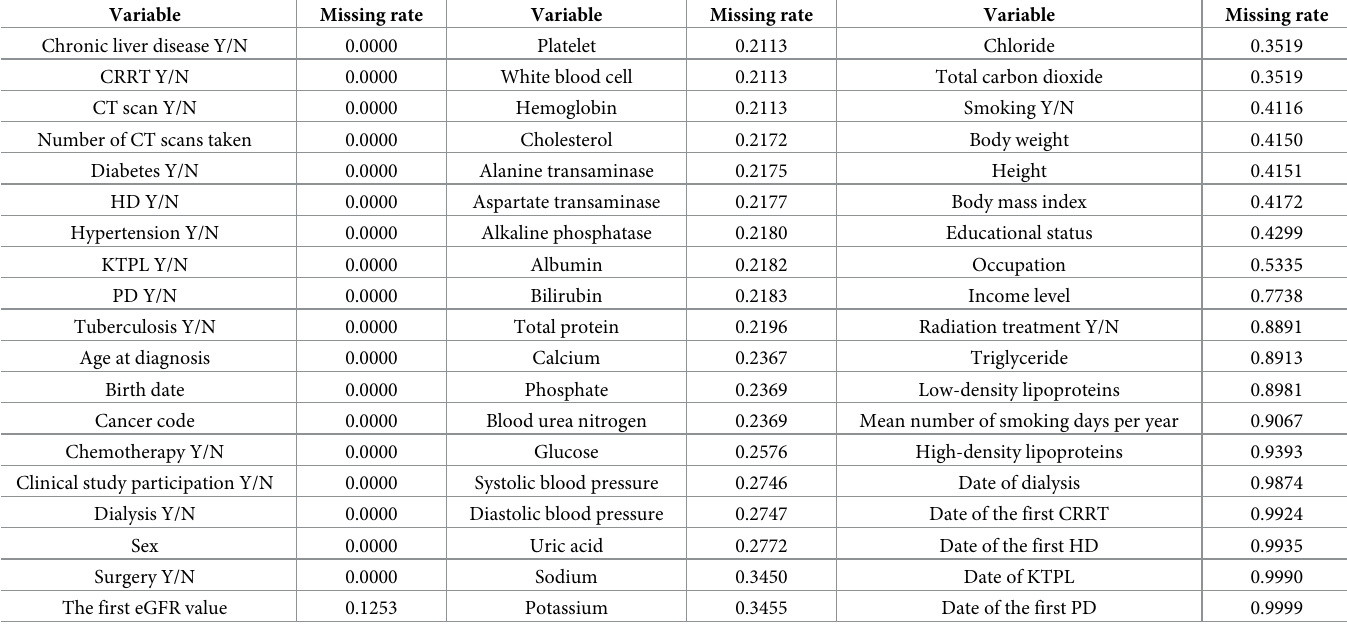
Table 3. Missing rate of non-temporal